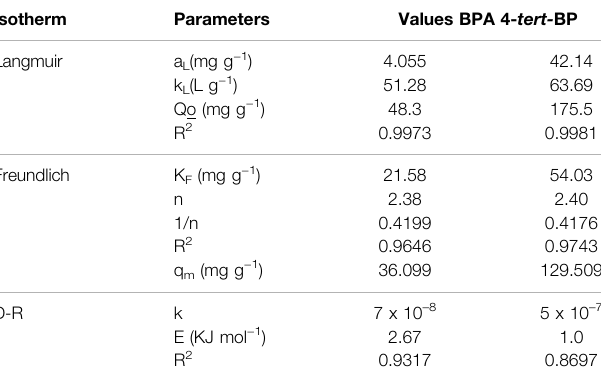
TABLE 2 | Isotherm parameters for BPA and 4- tert -BP adsorption onto MC